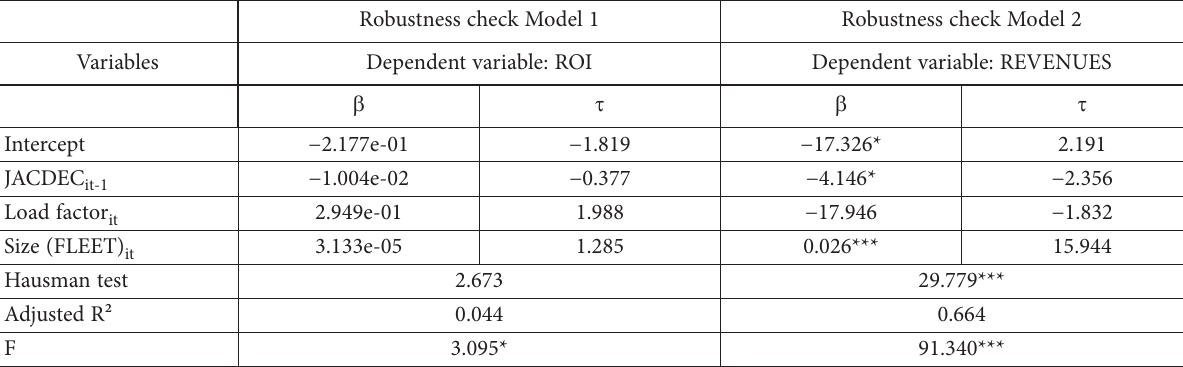
Table 4. Estimation models 1 and 2: Robustness check Robustness check Model